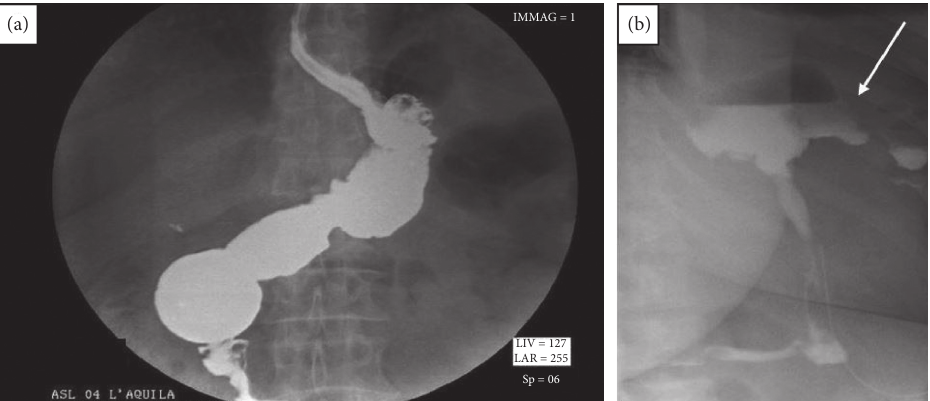
Figure 1: Gastrografin swallow test (GST). (a) Normal 2 nd POD GST: tightness of the linear suture is confirmed, and presence of gastric leak is excluded. (b) 2 nd POD GSTof our early complicated patient: it clearly shows the gastric leak (white arrow) close to the gastroesophageal junction near the angle of His.